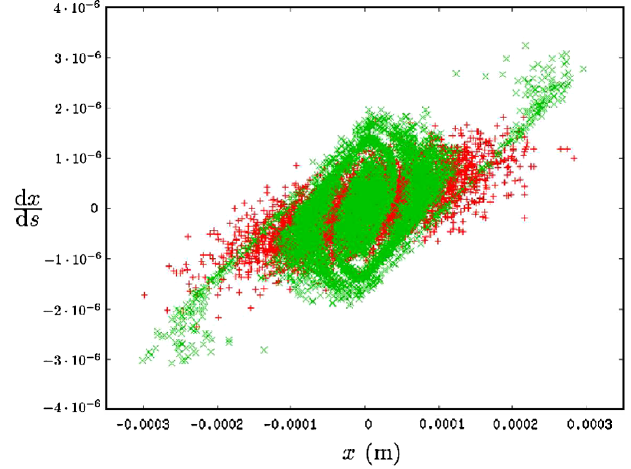
versing the 200 m ion field with (cid:9) (cid:9) (cid:5) 100 m at its center. Dark- red (cid:8) : phase space in a free drift; light-green (cid:4) : phase space for motion through the ion